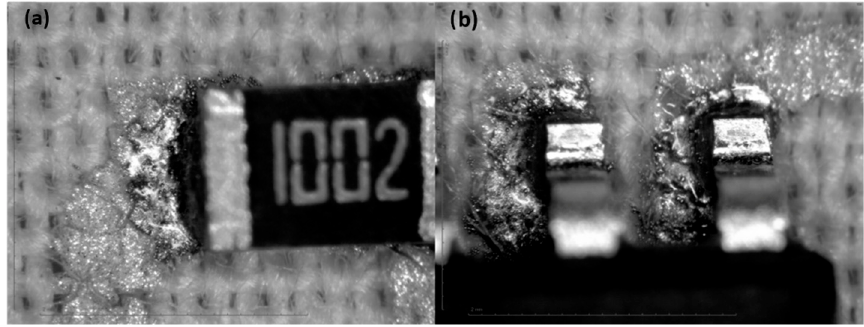
Figure 14. Soldering microscope pictures of 0805 ( a ) and SOIC8 ( b ) packages with solder paste Indium Indalloy #1E.